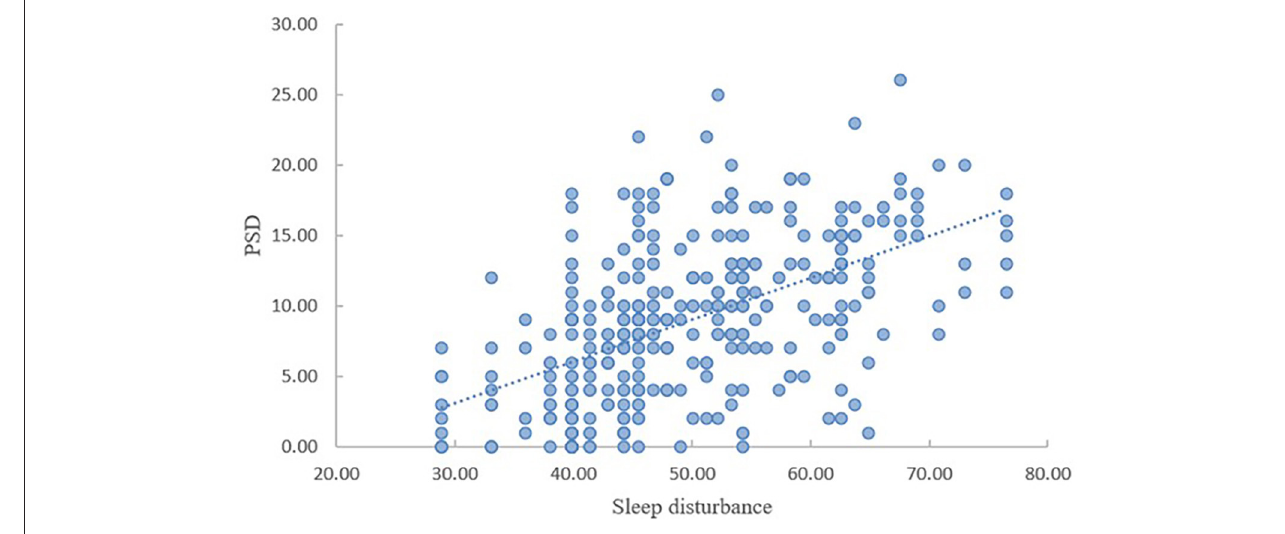
FIGURE 1 | The correlation between sleep disturbance and PSD.